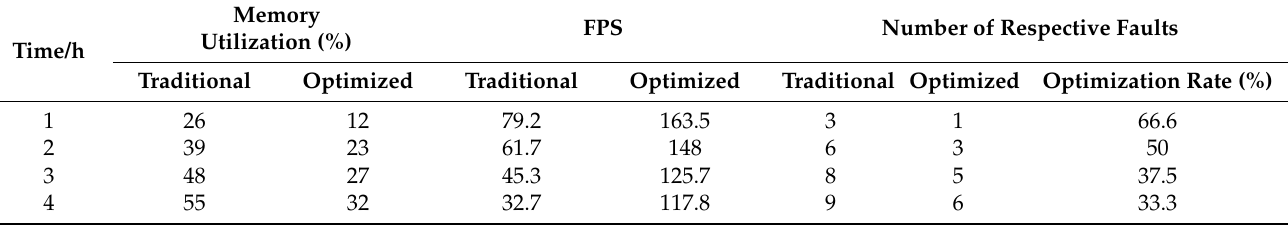
Table 3. Comparison of system operation data before and after optimization.